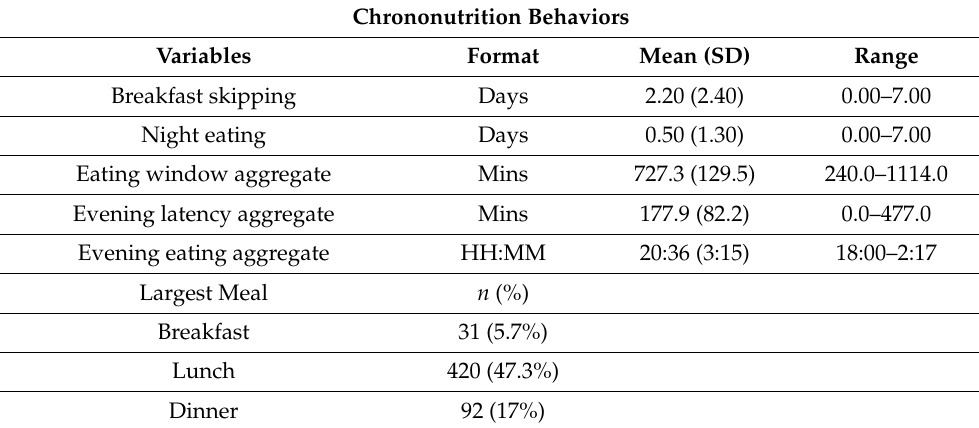
Table 2. Descriptive statistics of chrononutrition behaviors during the COVID-19 Lockdown.